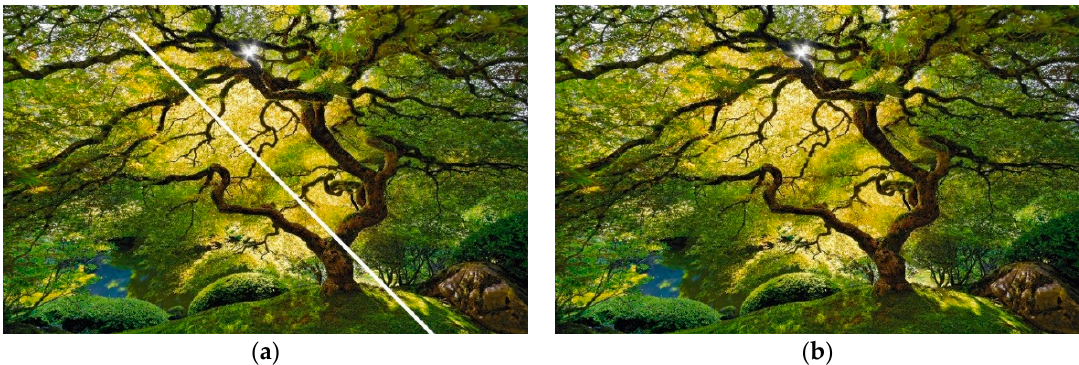
Figure 3. A sample of digital image in-painting: ( a ) Image with missing section; ( b ) Repaired Image after in-painting.